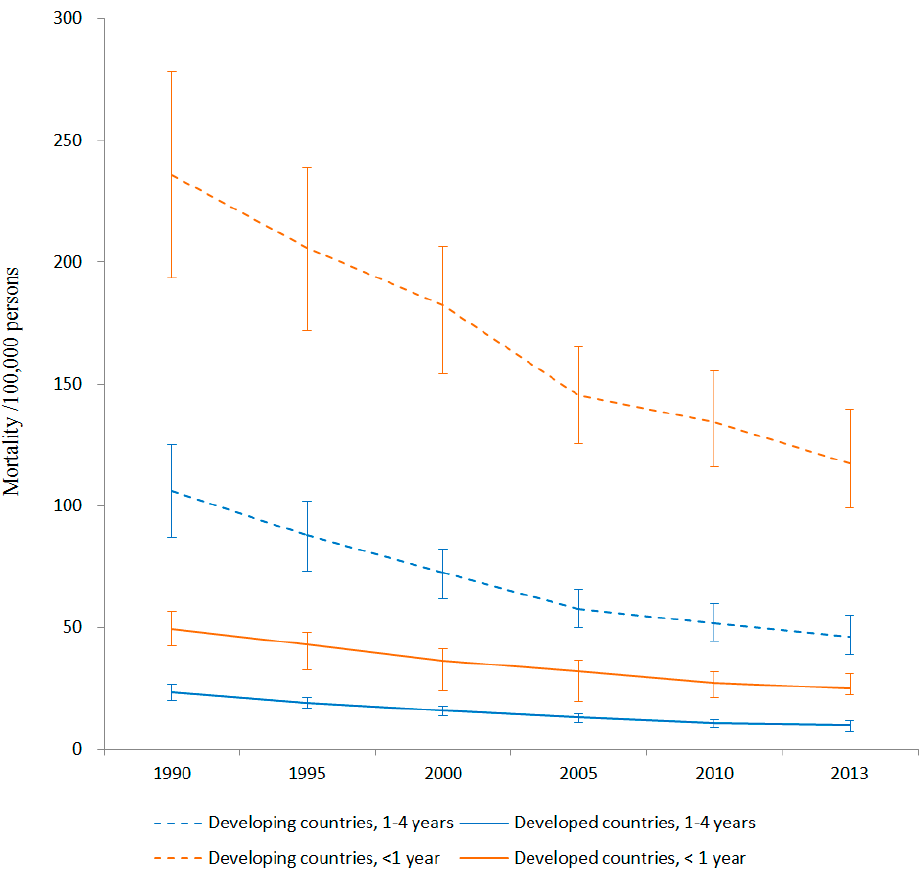
Figure 1. Global under-five child injury mortality per 100,000 persons by age and country income,